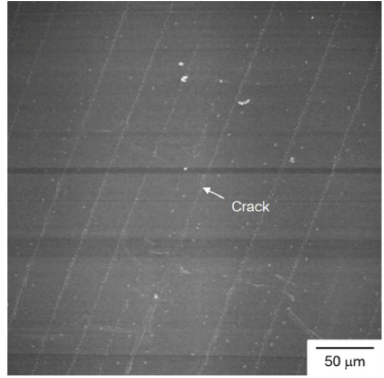
Figure 7. OM micrograph of ITO/PEN sheet after tensile bending with a 20 mm curvature radius for 1000 h, as viewed from the ITO side.